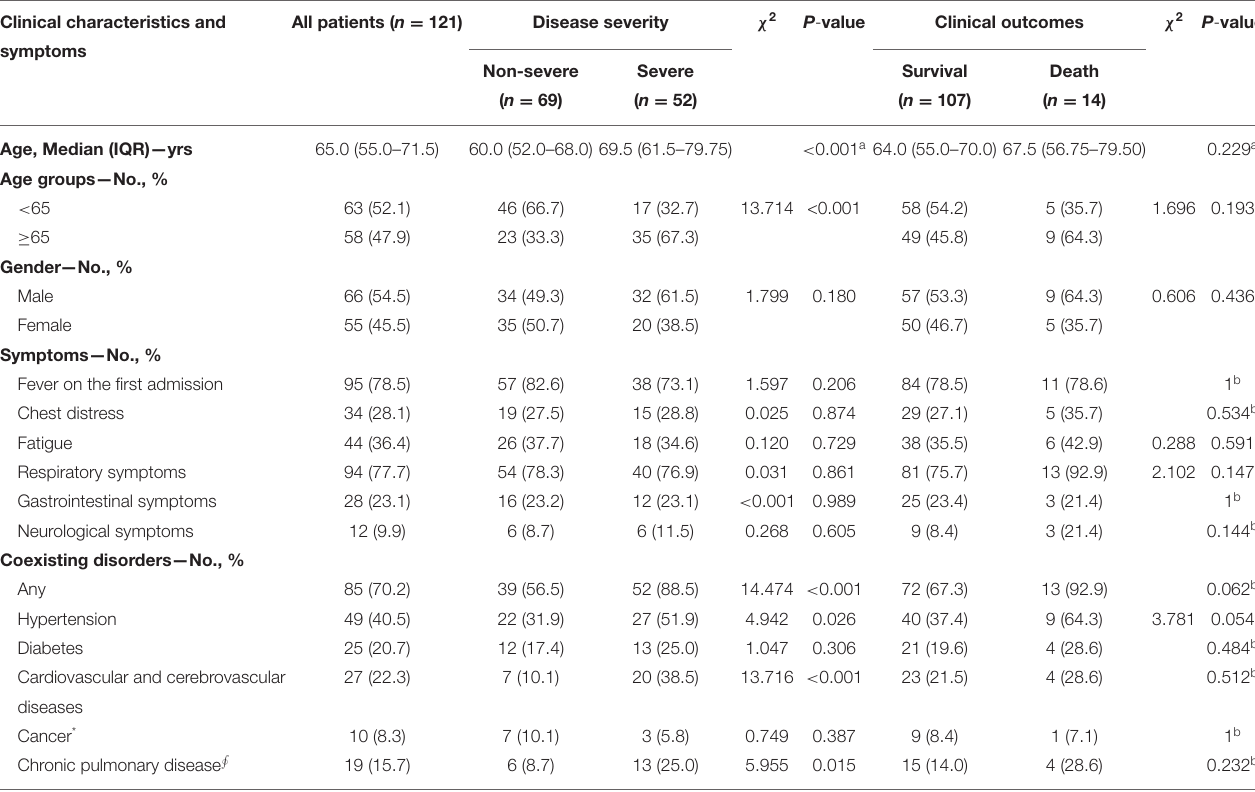
TABLE 1 | Demographic characteristics and initial clinical manifestations of patients with COVID-19 in Wuhan. Clinical characteristics and All patients ( n = 121) Disease